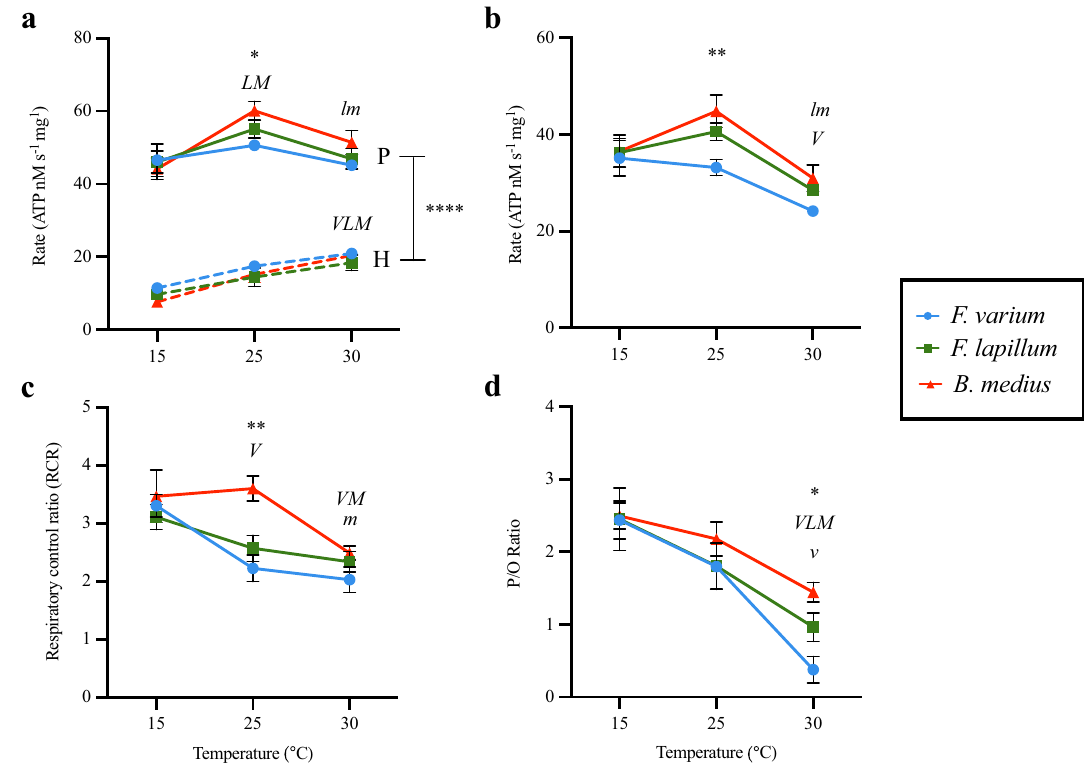
Figure 5. Rates of ATP production and hydrolysis with Respiratory control ratios (RCR) and P/O ratios for all three species at the experimental temperatures (15, 25 and 30 °C). ( a ) ATP production and ATP hydrolysis rates. ( b ) Net ATP production rate. ( c ) RCR’s were calculated as (CI&CII-OXPHOS-LEAK)/CI&CII-OXPHOS and represent the proportion of oxygen consumption coupled to energy production. ( d ) P/O ratios calculated as the rate of overall ATP production divided by O 2 consumption during CI&CII-OXPHOS. Significant differences between species within temperature of p ≤ 0.05 are denoted by an asterisk (*), significant differences of p ≤ 0.01 are denoted (**) while differences of p ≤ 0.0001 are denoted (****). Significant differences within species across temperature are represented by letters ( v/V = F.varium ; l/L = F. Lapillum; m/M = B. medius) . Capitalised letters represent differences from 15 °C while lowercase letters represent differences from 25